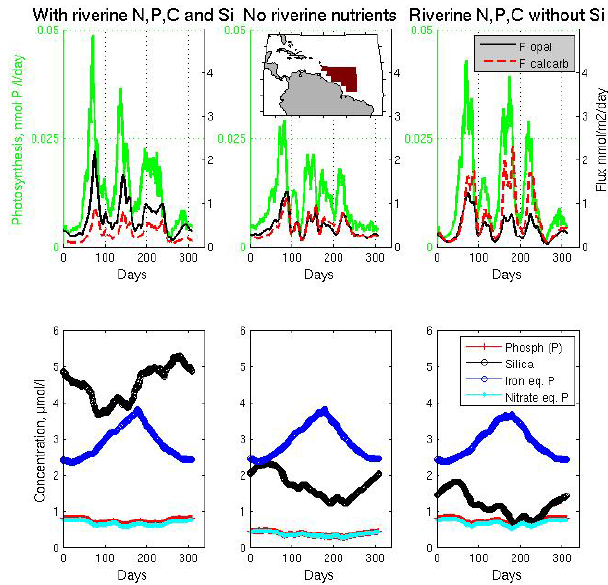
Fig. 3. The seasonal cycle of nutrient limitation (element equivalent phosphorous) in the Amazon plume region (1 . 74 × 10 6 km 2 , corre- sponding to 23 grid cells (275 × 275km), located between longitude 64 ◦ and 48 ◦ west, latitude 14.5 ◦ north and the coastline). Opal and calcium carbonate export (F opal and F calcarb) at 10m depth in response to photosynthesis (upper panels) with all riverine nutrients (left) and without any riverine nutrients (middle) or with riverine nutrients without DSi (right). Nutrient limitation (lower panels) is expressed as the concentration adjusted to the necessary stoichio- metric concentration of nitrogen and iron relative to phosphate. The limitation of photosynthesis is driven by the lowest concentration equivalent phosphate (iron, nitrate or phosphate). Opal and calcium carbonate competition is driven by the silica